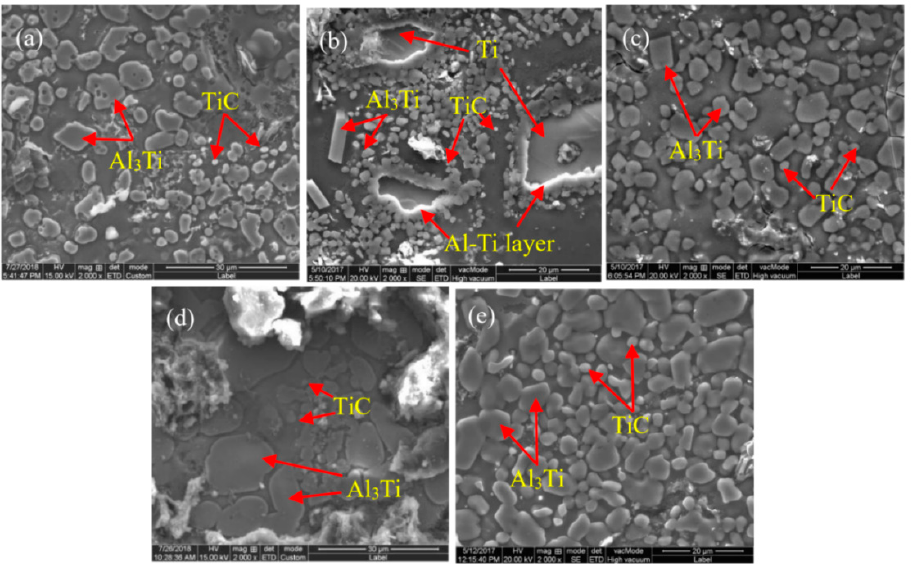
Figure 3. Scanning electron microscope (SEM) images of pressing blocks complete reaction of: ( a ) 1#; ( b ) 2#; ( c ) 3#; ( d ) 4#; ( e ) 5#.